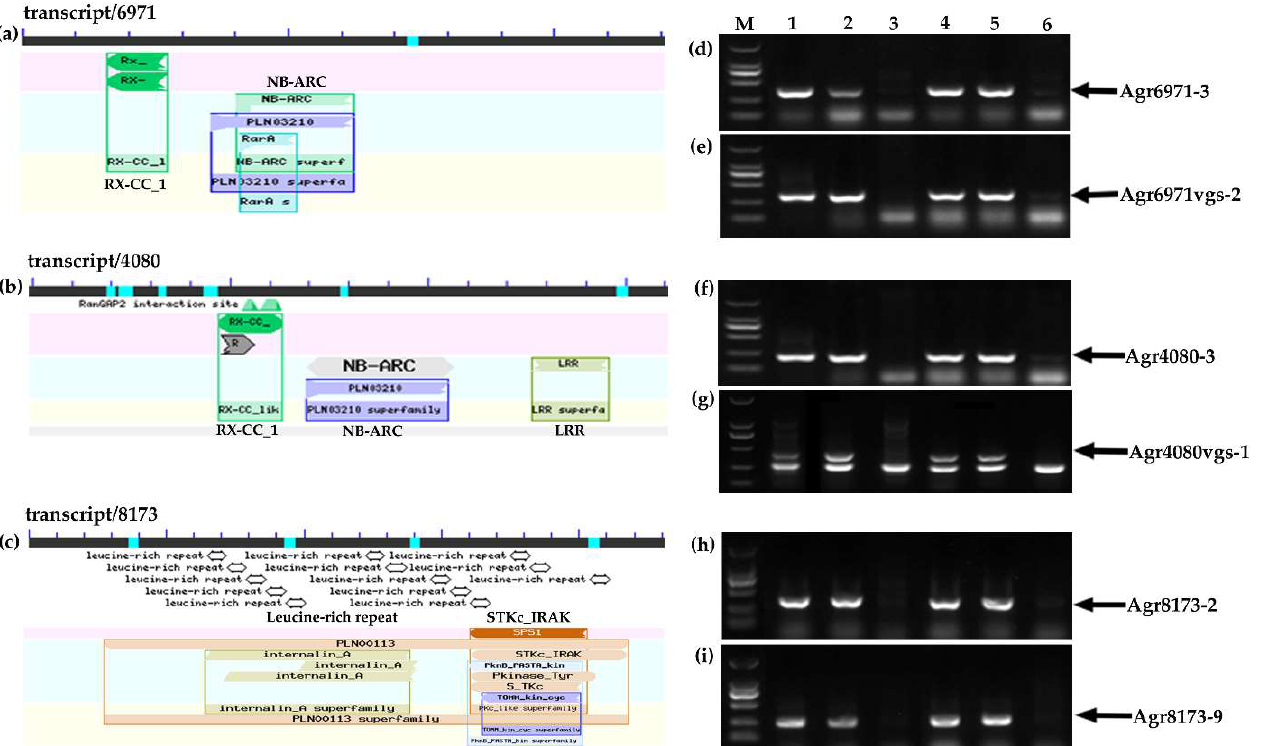
Figure 1. The functional annotations and the PCR amplification patterns of the molecular markers of three A . cristatum full-length transcripts. ( a – c ) The functional annotations of three full-length transcripts. ( d – i ) The gene-specific molecular markers of three full-length transcripts were used to trace A . cristatum 6PS (0.81–1.00). Lanes: M, DL2000 DNA marker; 1, Z559; 2, 4844-12; 3, Fukuho; 4, WAT655; 5, WAT638a; 6, WAT638b.